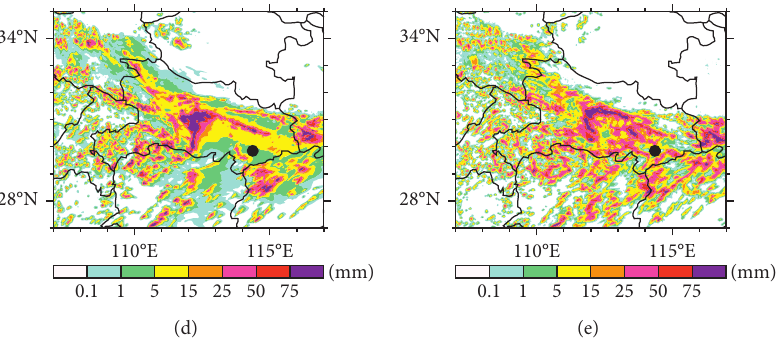
Figure 4: Longitude-latitude distribution of surface precipitation accumulated from 1800 UTC 29 June to 1200 UTC 30 June 2018 from (a) rain gauge observations and simulations of (b) THOM, (c) MOR_G/H, (d) SBU-YLIN, and (e) WDM6_G/H scheme.